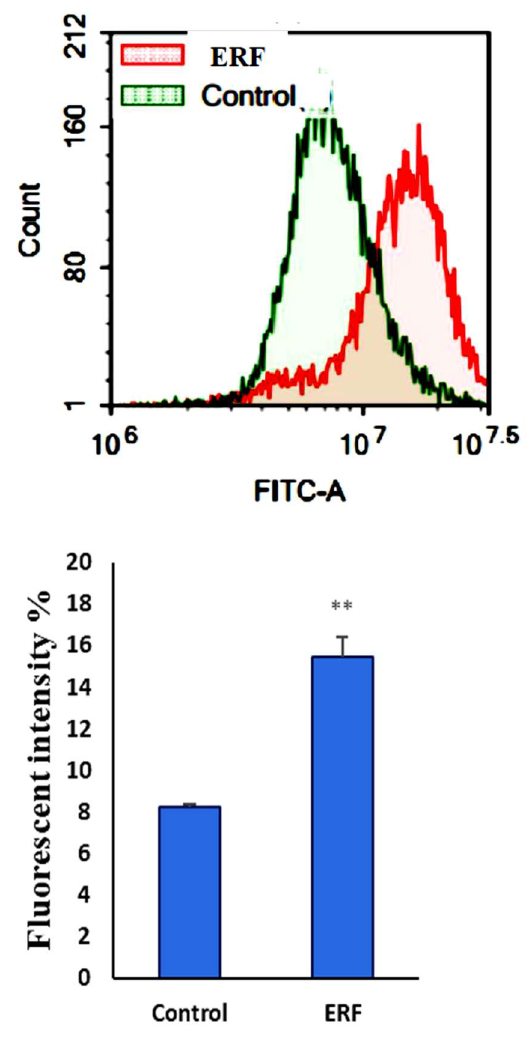
Figure 10. After being exposed to ERF, autophagic cell death was assessed in HepG2 cells. Cells were stained with a Cyto-ID autophagosome tracker after exposure to ERF for 24 h. ** Significantly different from the control group; data are presented as mean SD; n = 3.